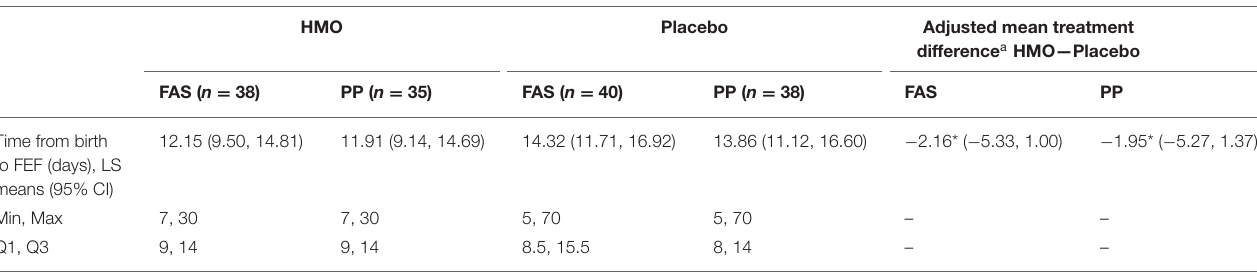
TABLE 3 | Time to reach full enteral feeding (FEF) by study arm, FAS, and PP